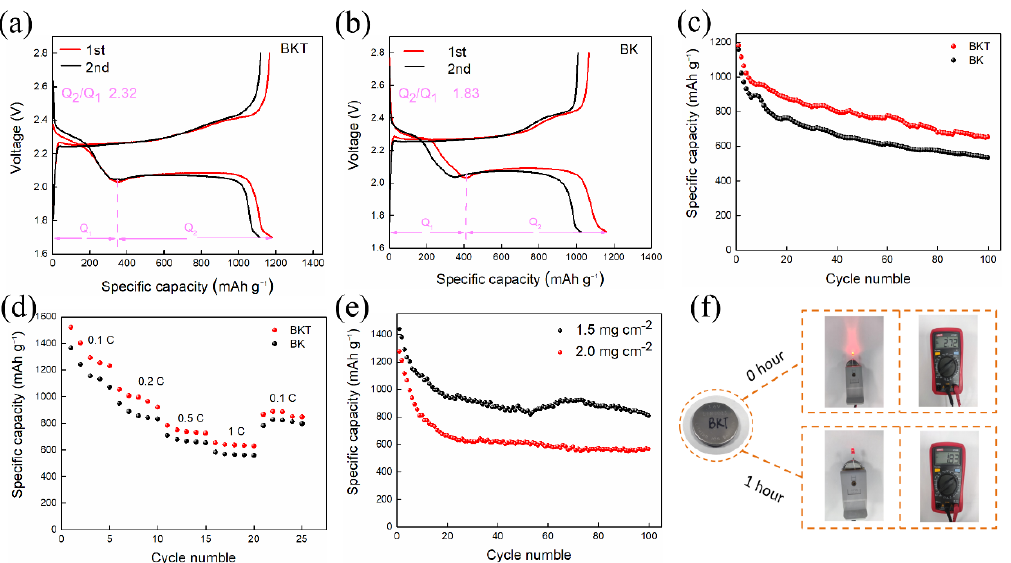
Figure 4. ( a , b ) The charge-discharge curves of BKT and BK separator-based batteries at 0.5 C current density for the 1.2 cycle; ( c ) 100-cycle long-cycle performance test of BKT and BK separator-based batteries at 0.5 C current density; ( d ) Multiplication test chart; ( e ) Long cycle diagram of BKT separator battery high sulfur loaded electrode; ( f ) Diagram of BKT separator battery lighting small bulb.